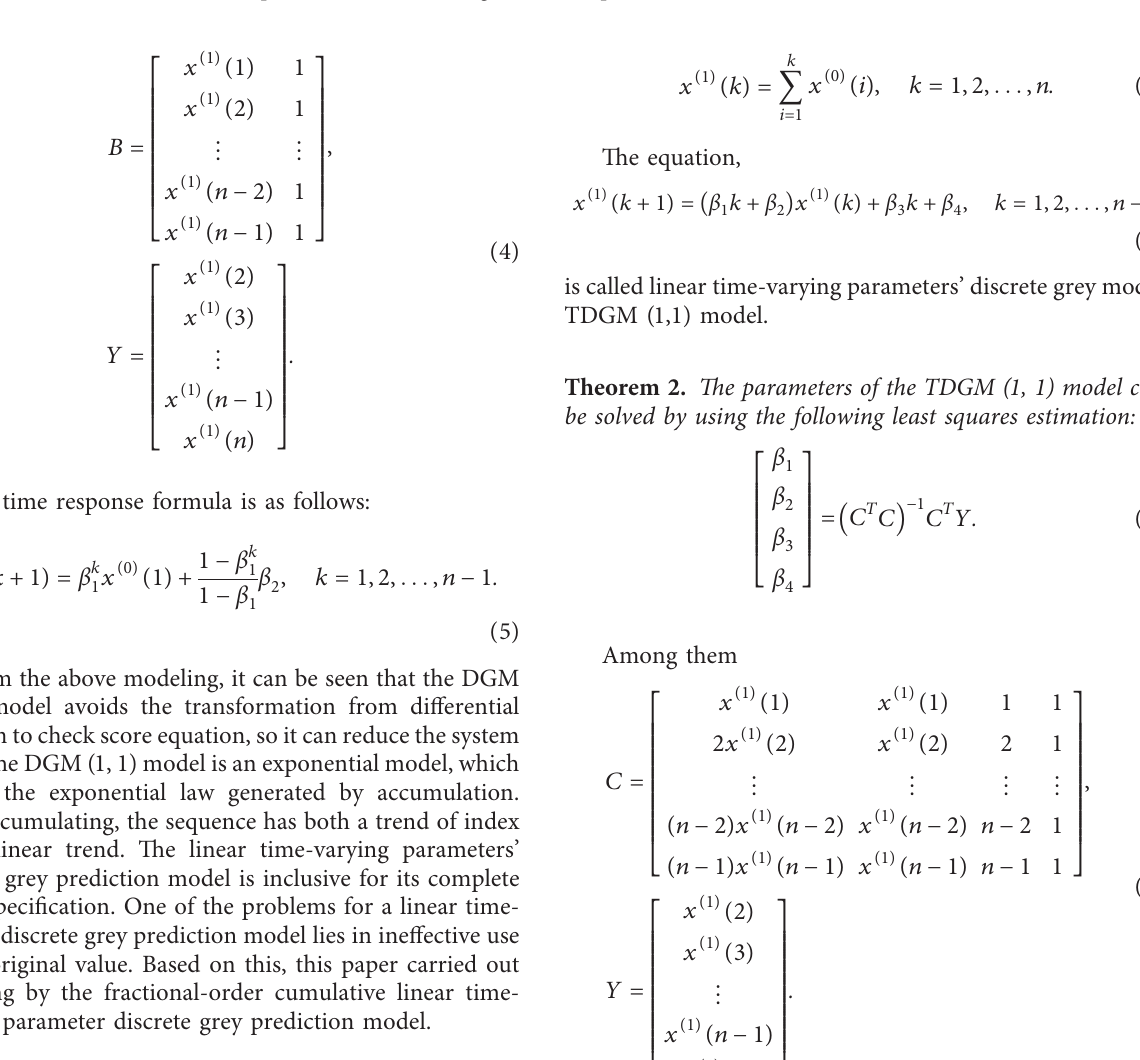
Figure 1: Comparison between the original data sequence and its first-order